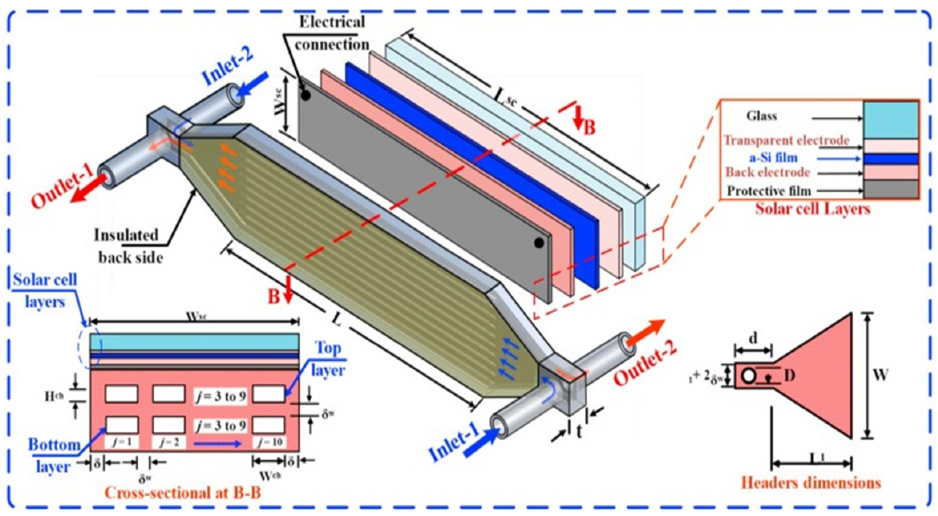
Figure 17. Schematic diagram of double-layer microchannel (adapted from Ref. [117]).